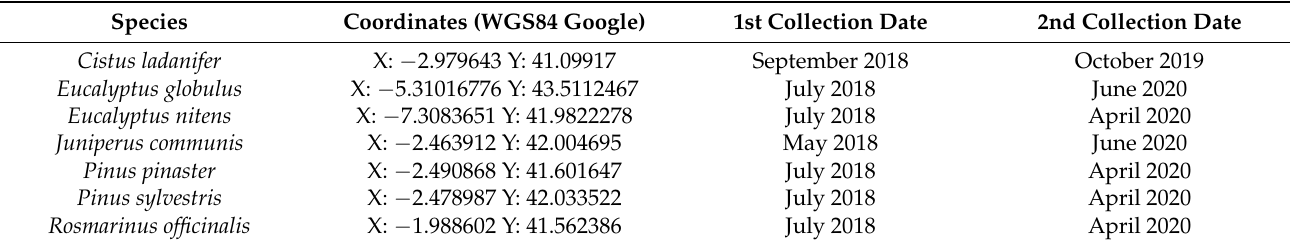
Table 4. Location and date of the plant material